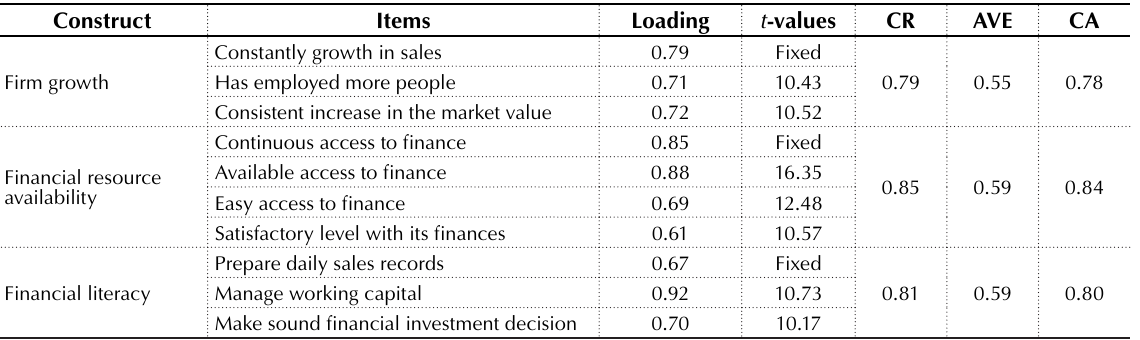
Table 3. Confirmatory analysis